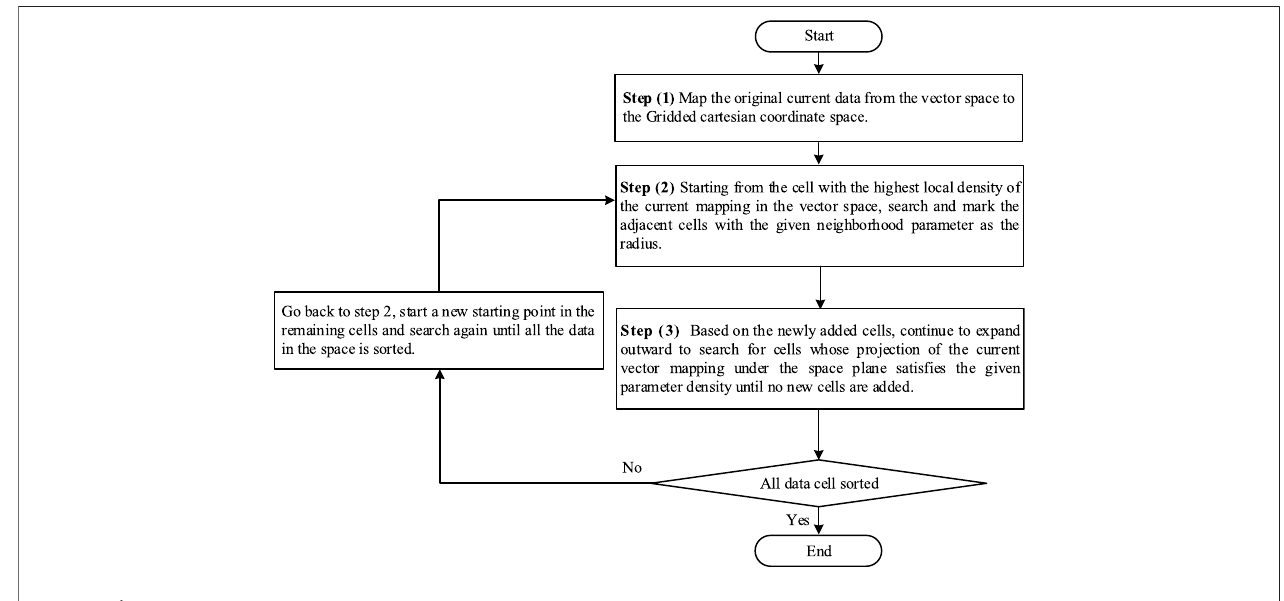
FIGURE 6 | Flowchart of the current vector NGC clustering